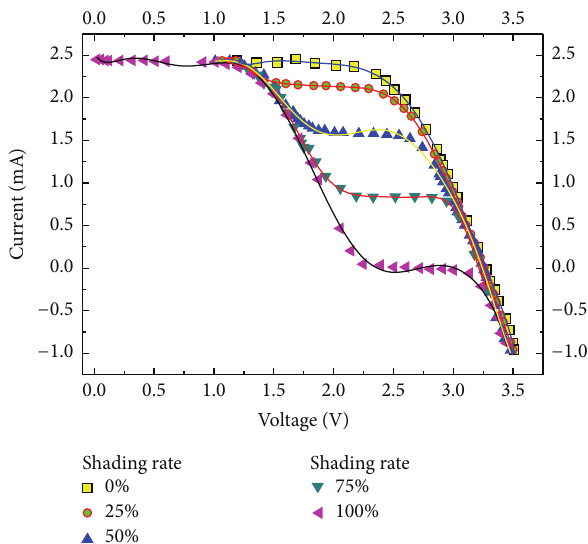
Figure 9: I-V characteristics experimental data for different shading rates illustrated as